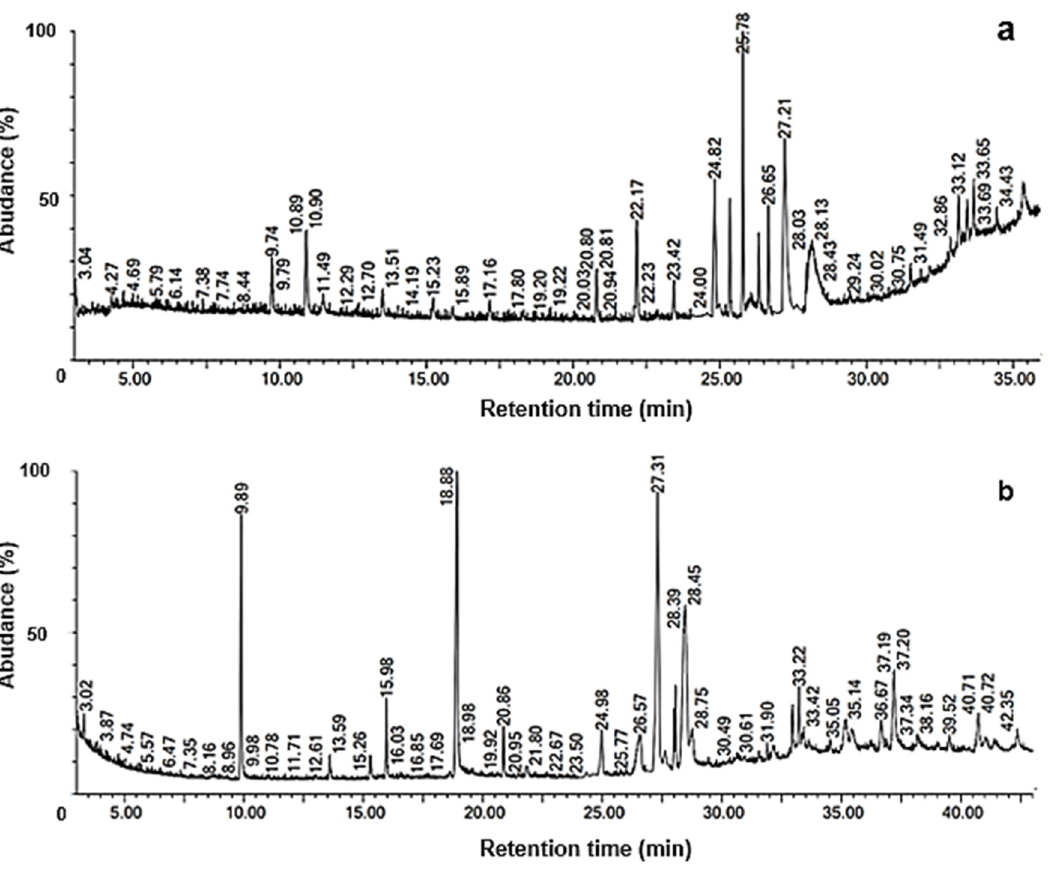
Figure 2. Chromatograms of GC–MS profile from post-fermented substrates ( a ) oat straw and ( b ) wheat brand.